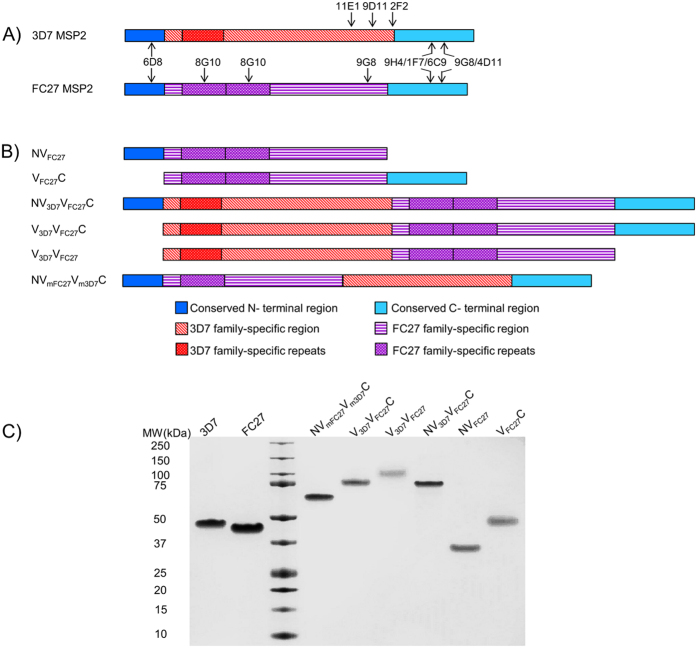
(A) Schematic representation of recombinant 3D7 and FC27 MSP2 constructs and the binding regions of previously identified mouse monoclonal antibodies19. (B) Representation of truncated and chimeric MSP2 constructs used in this work. Truncated constructs were derived from the excision of either conserved N-terminal or C-terminal regions. Chimeric constructs were generated by the fusion of 3D7 and FC27 variable regions in the presence or absence of the conserved N- or C-terminus. (C) SDS-PAGE analysis of purified full-length 3D7 MSP2, FC27 MSP2 and other MSP2 constructs: NVFC27 - FC27 MSP2 without the CTR (FC27 MSP21–171); VFC27C - FC27 MSP2 without NTR (FC27 MSP226–221); NV3D7VFC27C - NTR, 3D7 MSP21–179 followed by FC27 MSP226–171 (with two 12-residue repeats) and CTR; V3D7VFC27C- 3D7 MSP226–179 followed by the FC27 MSP226–171 and CTR; V3D7VFC27- VR of 3D7 MSP226–179 followed by the VR of FC27 MSP226–171; NVmFC27Vm3D7C - NTR, followed by the modified variable regions of FC27 MSP264–171, 3D7 MSP258–179 and CTR. Gel was loaded with 1.25 µg of protein per well and stained with Coomassie Blue.